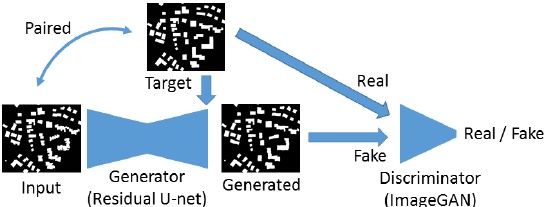
Figure 3. ImageGAN as generative adversarial network (GAN) discriminator.